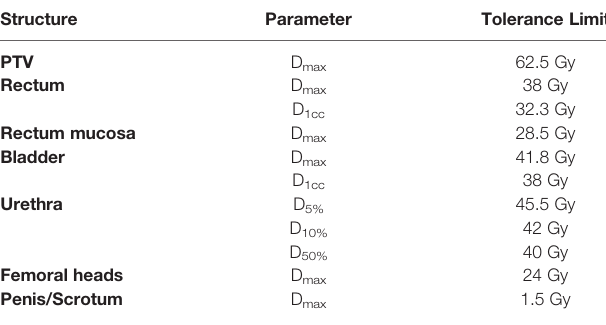
TABLE 1 | Clinically applied dose constraints for prostate SBRT.